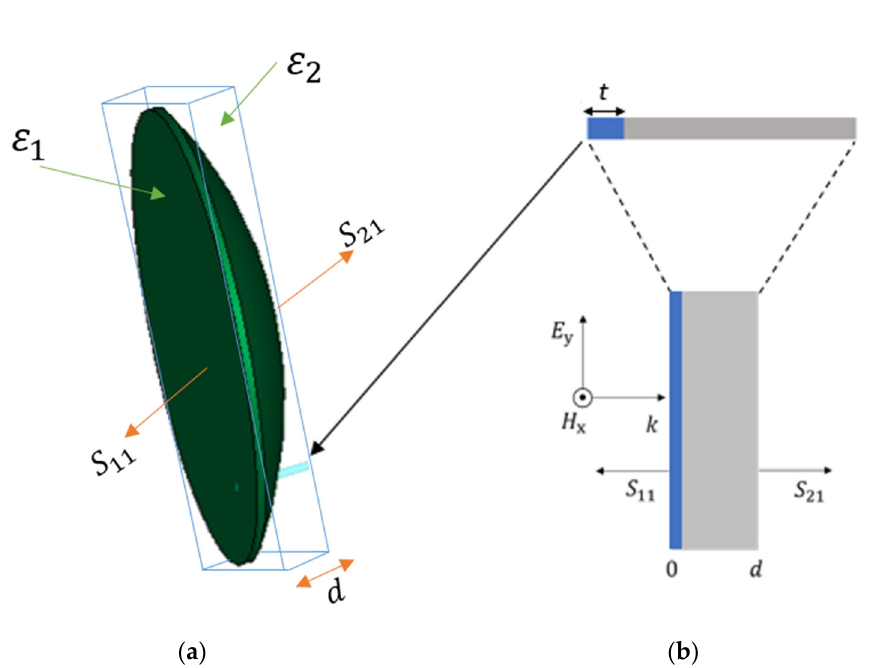
Figure 1. Physical model of a small position on the semi-spherical lens. ( a ) Semi-spherical lens, and ( b ) the effective slab of this position.